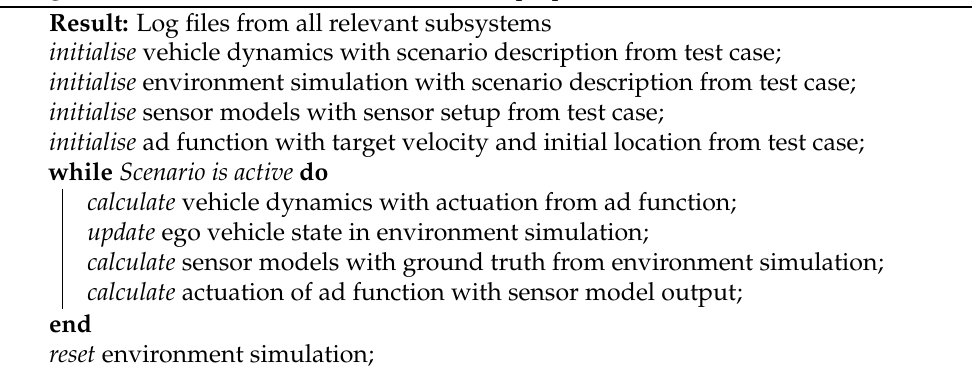
Algorithm 1: Simulation of a test case with the proposed co-simulation framework.